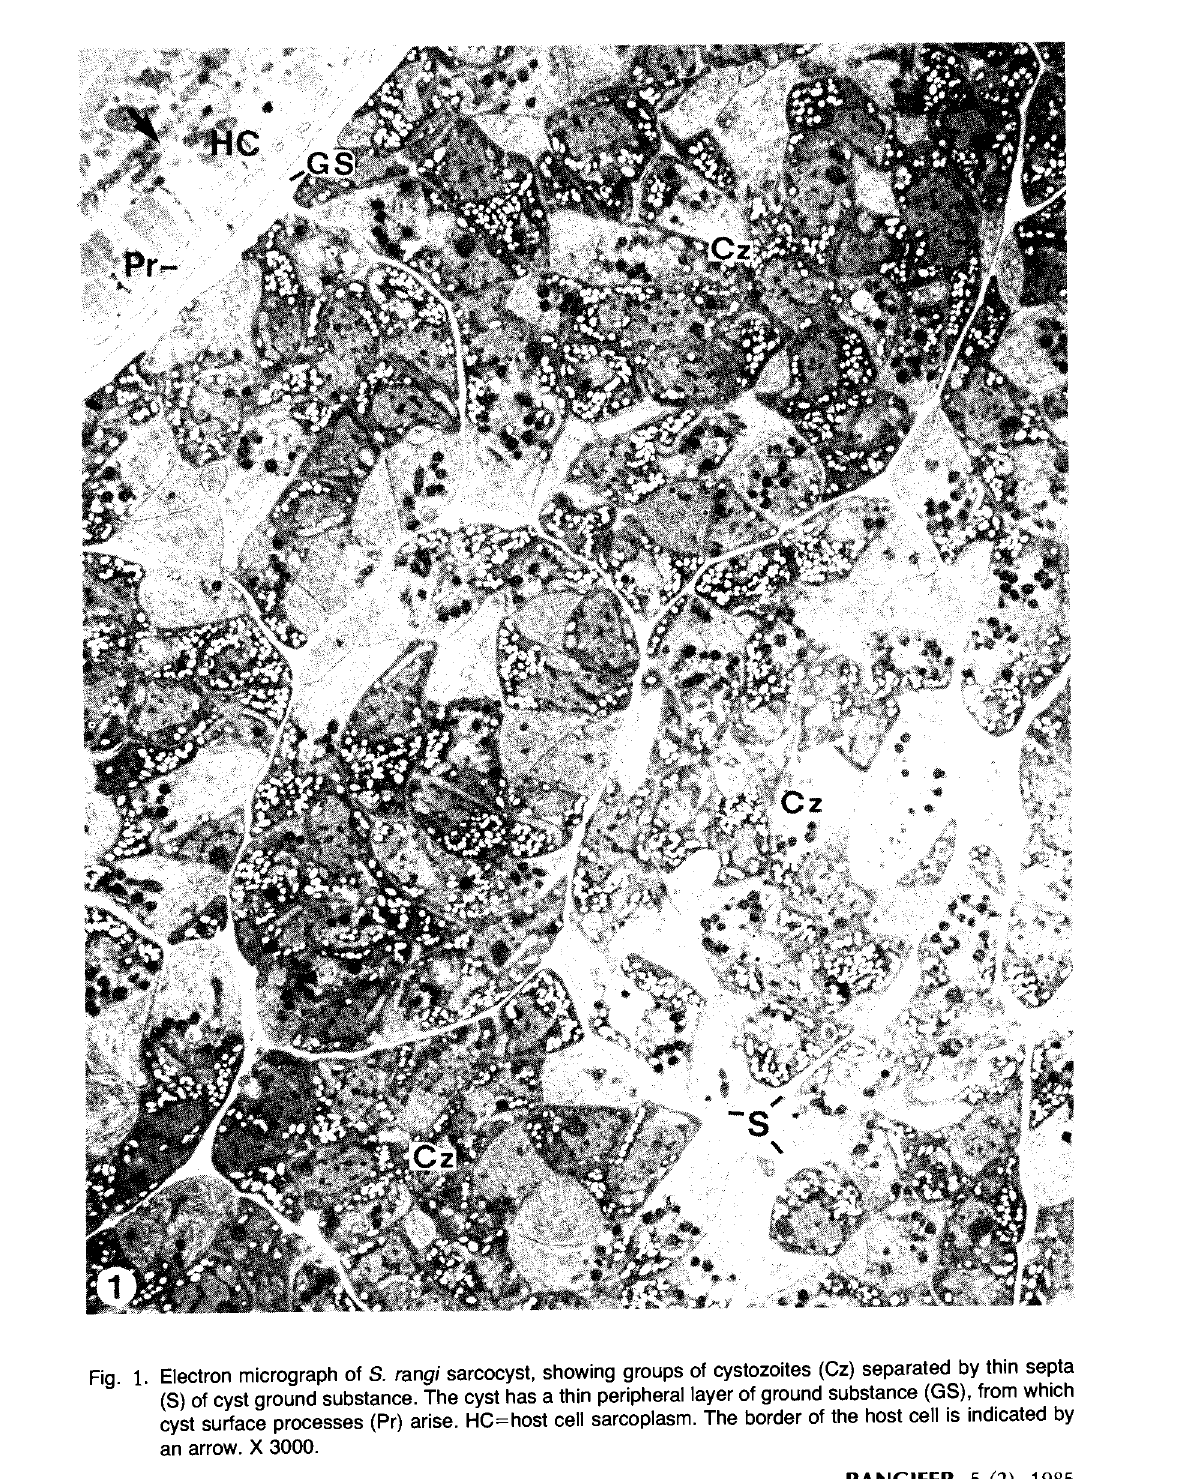
Fig. 1. Electron micrograph of S. rangi sarcocyst, showing groups of cystozoites (Cz) separated by thin septa (S) of cyst ground substance. The cyst has a thin peripheral layer of ground substance (GS), from which cyst surface processes (Pr) arise. HC=host cell sarcoplasm. The border of the host cell is indicated by an arrow. X